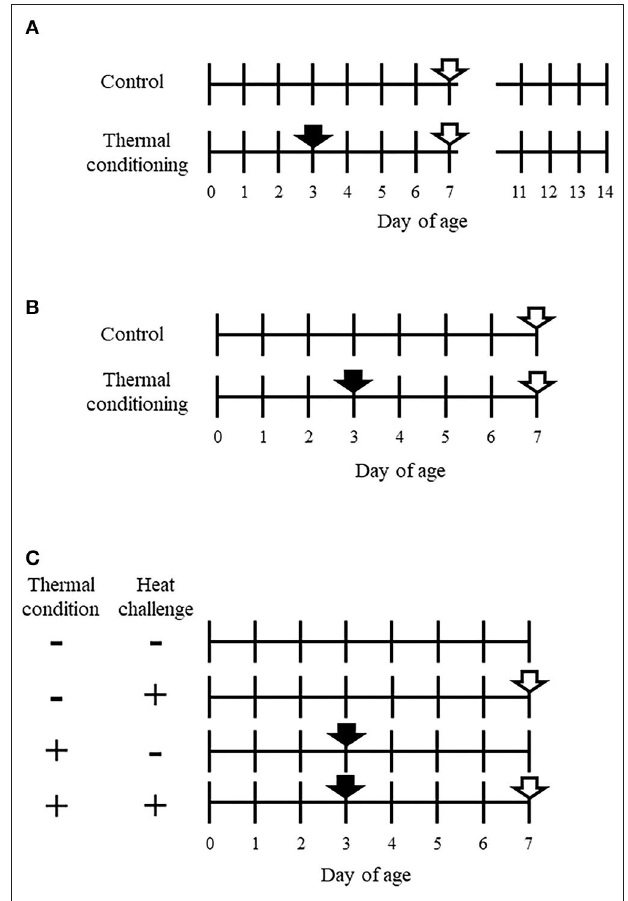
FIGURE 1 | Experimental designs of this study. (A) Design of experiment 1. A closed arrow indicates the thermal conditioning treatment. Closed arrows indicate time points of sampling for collecting pectoral muscle. The total number of chicks was 32, with 16 chicks per group. The Pectoral muscle tissue was collected from half of the chicks in each group at 7 days old. Other Body weight was measured daily from 2 to 14 days of age in the other half of the chicks in each group. (B) Design of experiment 2. A closed arrow shows thermal conditioning and open arrows show heat challenge. The number of chicks was eight per group. (C) Design of experiment 3. + indicates treated and – indicates non-treated. Closed arrows show thermal conditioning treatment and open arrows indicate heat challenge. The number of chicks was eight per group. Four chicks were used for metabolome analysis in each group.